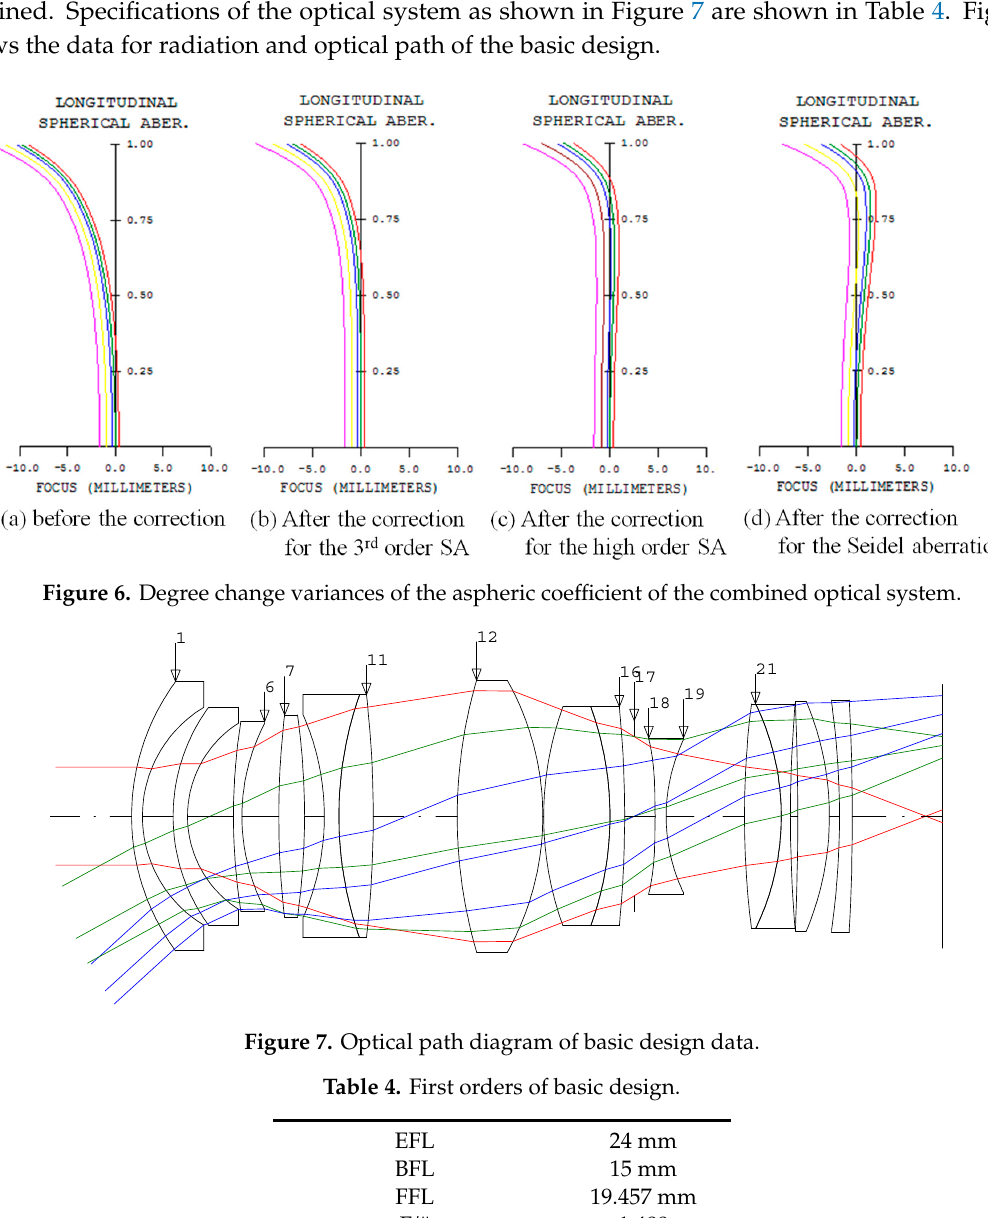
Figure 6. Degree change variances of the aspheric coefficient of the combined optical system.